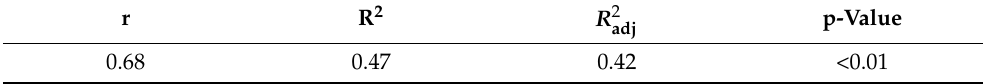
Table 5. NDVI climate reconstruction equation characteristic statistical